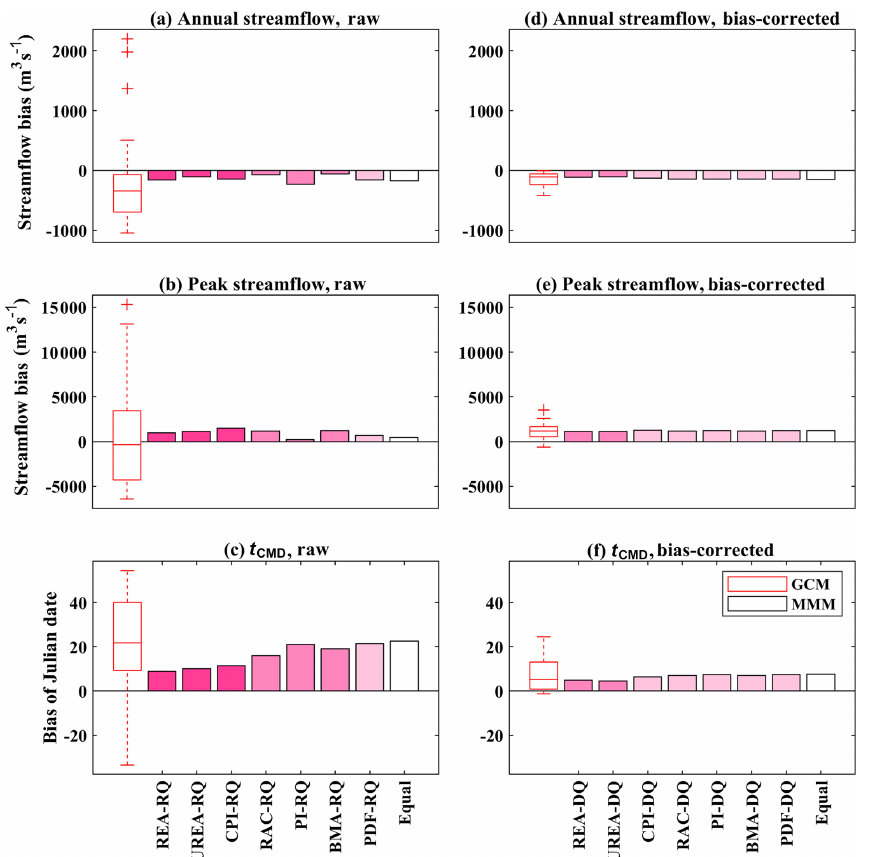
Figure 5. Bias in mean annual streamflow, mean peak streamflow, and mean center of timing of annual flow ( t CMD ) simulated using 29 raw or bias-corrected GCM outputs and the multi-model means (MMM) combined by weights based on raw ( RQ ) and bias-corrected ( DQ ) GCM-simulated streamflows in the Xiangjiang watershed in the reference period. (The depth of pink in the MMM bars represents the level of inequality of weights, as indicated in Table